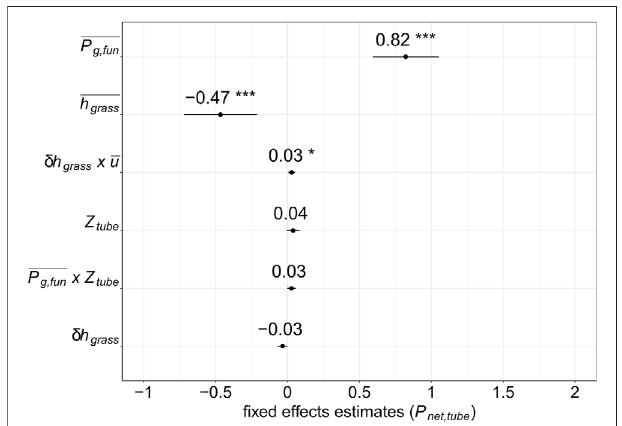
FIGURE 10 | Factors affecting net precipitation measurement (P net , tube ) during the covered period. Values on the x -axis indicate the slope of the relations. Signi fi cant predictors are: weekly measured mean gross precipitation ( P g , fun ), mean ( h grass ), the spatial deviation of grass height from themean ( δ h grass ),average wind speed ( (cid:1) u ) , elevation of interception tube locations (Z tube ). All variables were scaled with Z transformation. Interaction is shown with ‘ x ’ Signi fi cance code *** is 0, ** is 0.001, * is